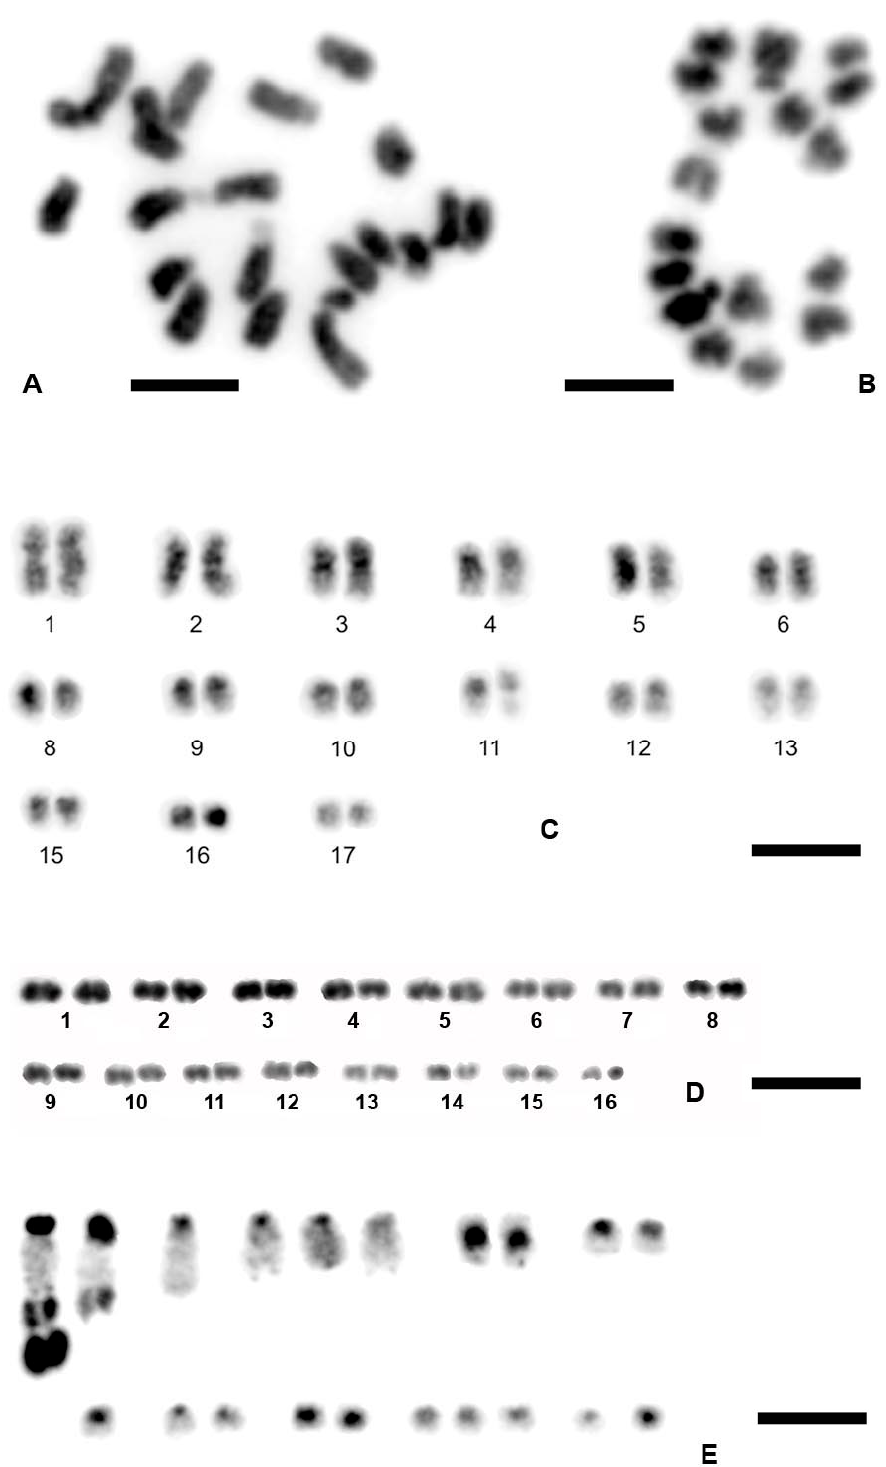
Figure 4. Chromosomes of other non-marine ostracod species. ( A ) C. marginata , a sexual female, Gauting, Germany; ( B ) C. marginata , a male, Gauting, Germany; ( C ) B. fuscata , Gauting, Germany, an asexual female (males are unknown in Europe); ( D ) C. pubera , a diploid asexual female, Gauting, Germany; ( E ) H. incongruens , Sicily, a diploid asexual female. Chromosome preparations were stained with DAPI and inverted. Scale bars indicate 3 µm.